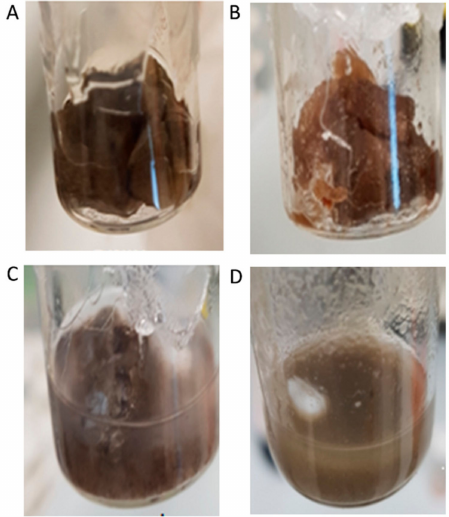
Figure 3. Red-algae polysaccharide-based PdCl 2 (TPPTS) 2 catalysts after 24 h at 60 ◦ C in ethanol: ( A ) i ; ( B ) κ ; ( C ) λ ; ( D ) P